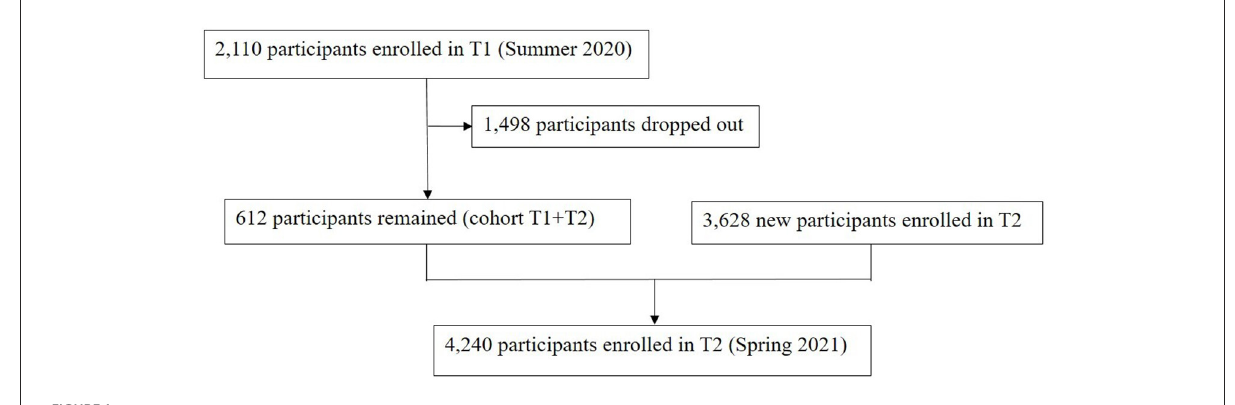
FIGURE1 Study flow